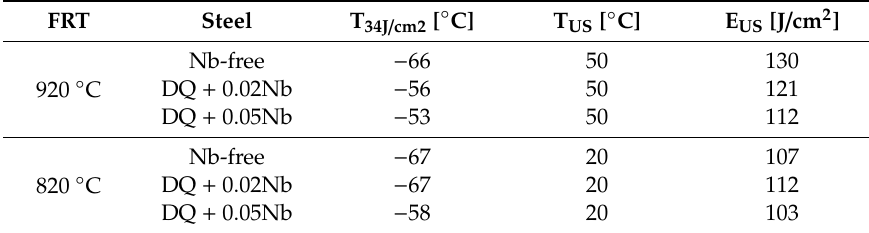
Table 7. Charpy V impact properties of the investigated steels in rolling direction. FRT Steel T 34J / cm2 [ ◦ C] T US [ ◦ C] E US [J / cm 2 ] Nb-free − 66 50 130 DQ + 0.02Nb − 56 50 121 920 ◦ C DQ + 0.05Nb − 53 50 112 Nb-free − 67 20 107 DQ + 0.02Nb − 67 20 112 820 ◦ C DQ + 0.05Nb − 58 20